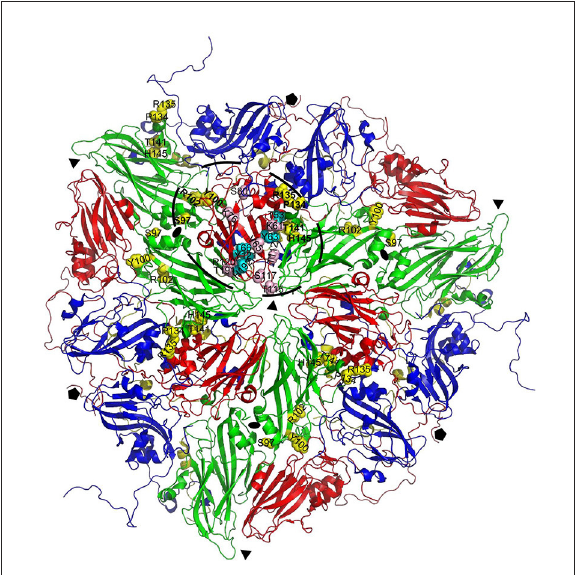
FIGURE3 Location of VP2 residues cross-linked to M702F relative to VP3 cross-linked residues. Cross-linked residues are mapped onto a cartoon presentation of the A22IRQ structure (PDB: 4GH4). Six protomers that originate from three different 12S pentamers surrounding the 3-fold symmetry axis are shown. M702F cross-linked residues are shown for VP3 of the protomer on top and the 4 VP2 molecules closest to this VP3 molecule. The VP2 residues closest to the cross-linked VP3 residues (bold) most likely form the same antigenic site (dashed oval). VP1, blue; VP2, green; VP3, red; VP4, yellow. Cross-linked residues are shown with side chains as yellow (VP2) or cyan/pink (VP3) spheres. Symmetry axes: 5-fold, pentagon; 3-fold, triangle; 2-fold, oval.